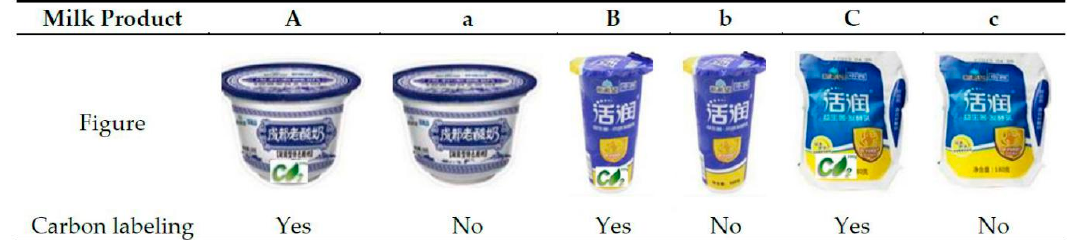
Figure 2. Experimental milk products with and without carbon labels.